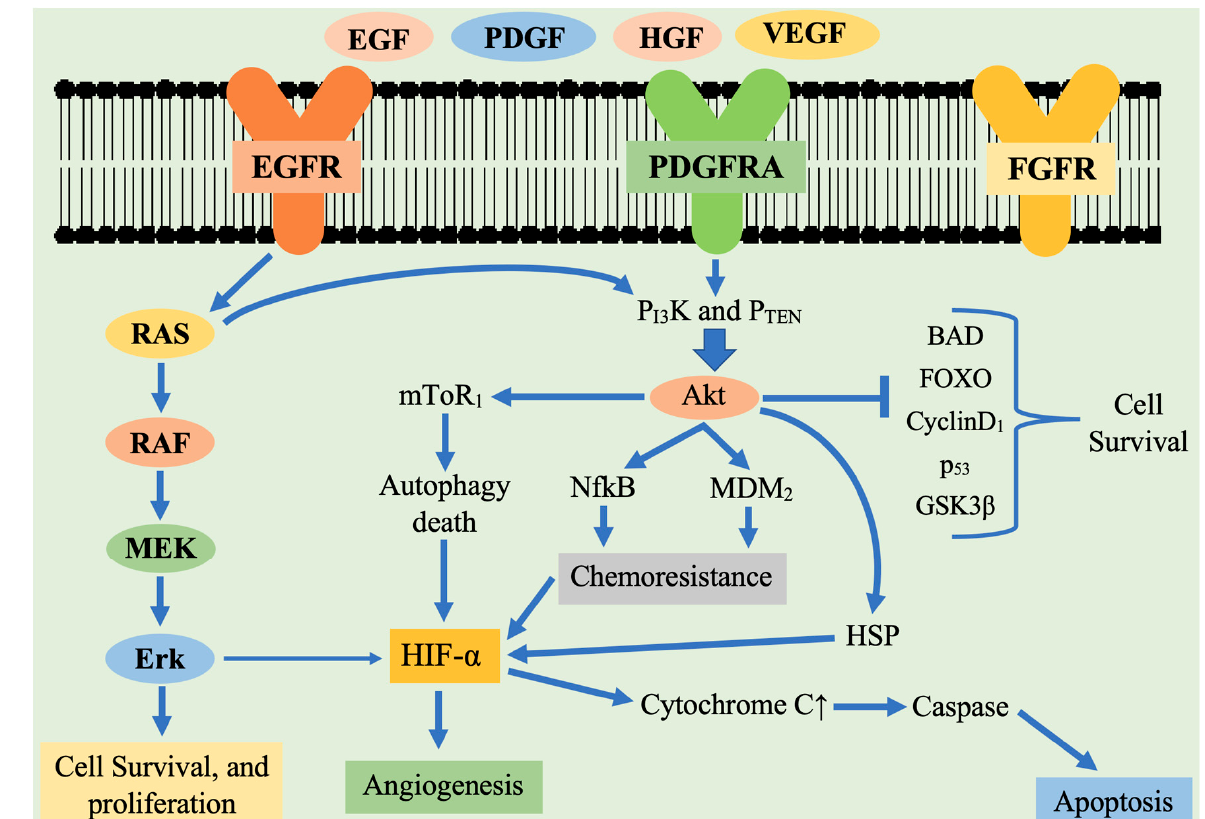
Figure 1. Schematic representation of tyrosine kinase receptor activation and the major downstream signaling pathways involved in the pathogenesis of glioblastoma multiforme. Receptor tyrosine kinase are activated by ligand binding causing receptor dimerization and auto phosphorylation of the tyrosine kinase domain. This results in activation of two main downstream signaling pathways: Ras/ERK and PI3K/AKT. These receptors activate downstream signaling cascade that participates in cell survival, proliferation, angiogenesis. Legend: EGF—endothelial growth factor; EGFR—epidermal growth factor receptor; PDGF—platelet derived growth factor; PDGFR—platelet derived growth factor receptor; VEGF— vascular endothelial growth factor; VEGFR—vascular endothelial growth factor receptor; mTOR 1—mammalian target of